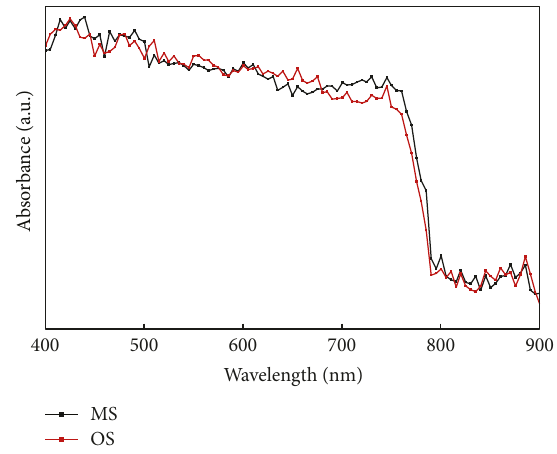
fi lms NH PbI Cl 3 3 3-X X